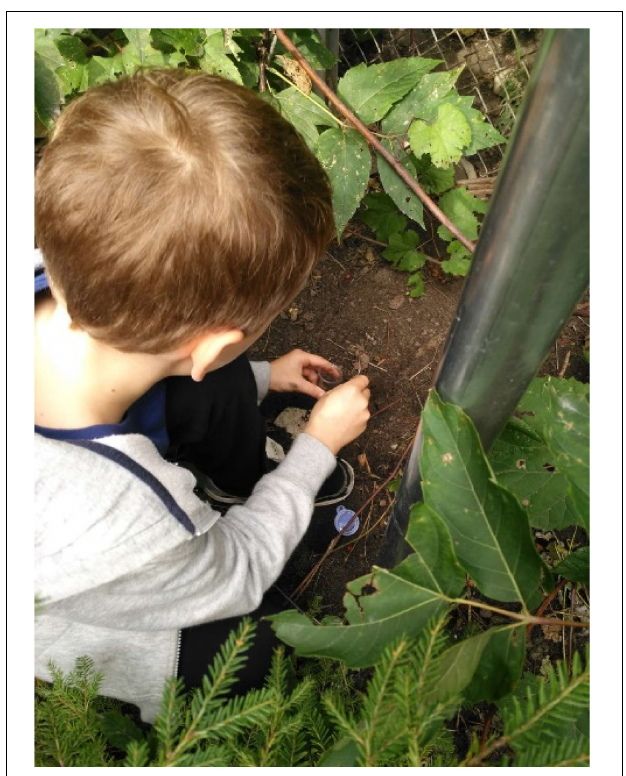
FIGURE 5 | A grade 3 student collecting a soil